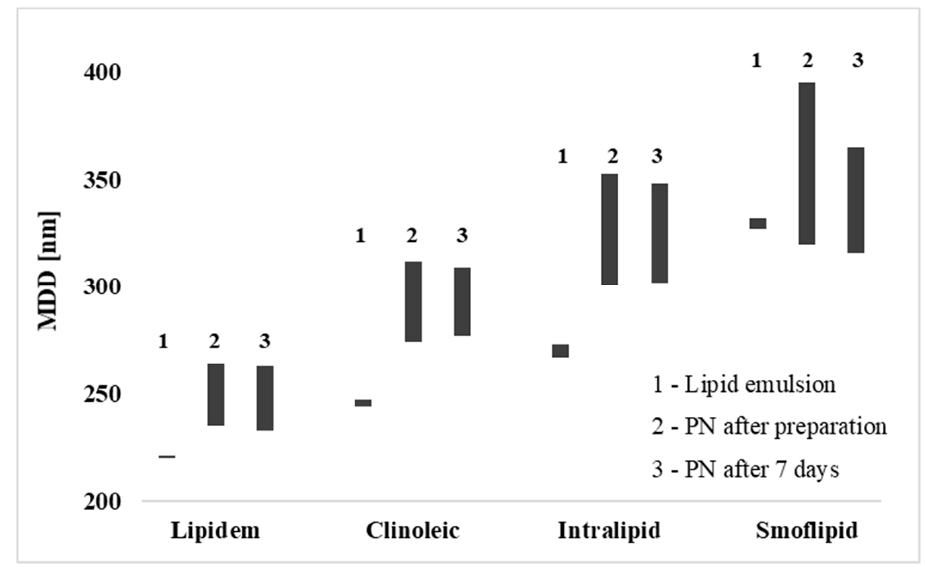
Figure 2. Mean droplet diameter range for studied PN admixtures and used lipid emulsions.